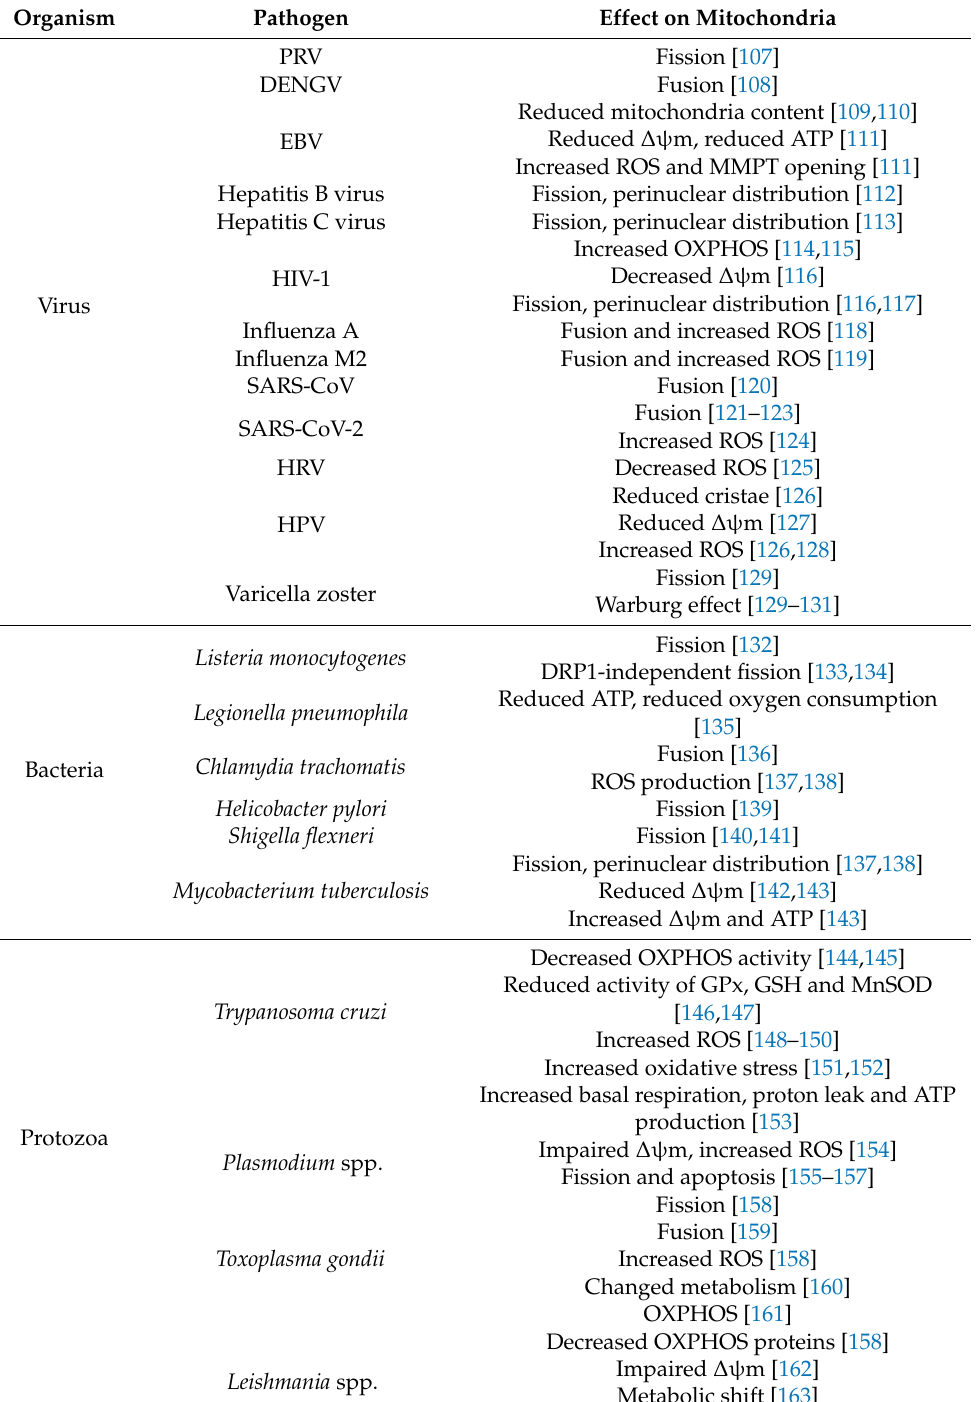
Table 1. Effect caused by bacteria, protozoan and viruses on mitochondria bioenergetics and dynamics.